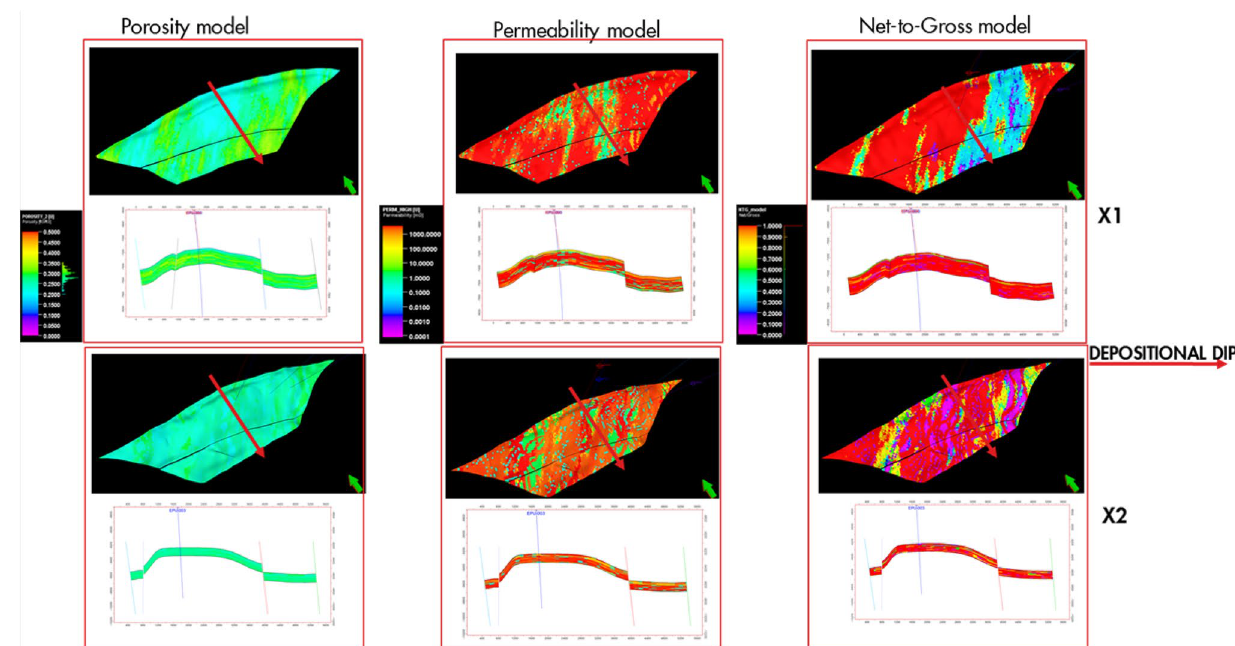
Fig. 17 Petrophysical models showing porosity, permeability and net-to-gross distribution in X1 and X2